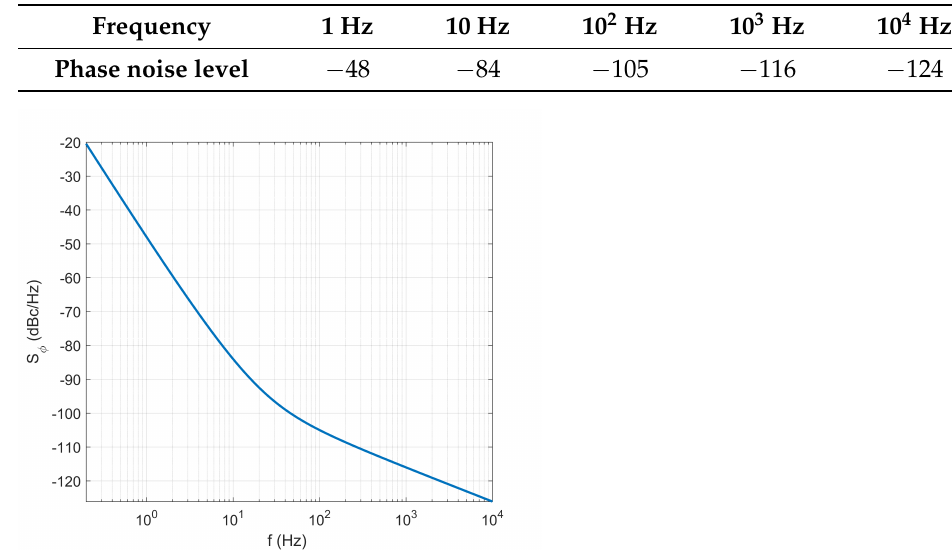
Table 2. Example of Single Sideband Phase Noise Levels, Given in dBc/Hz.